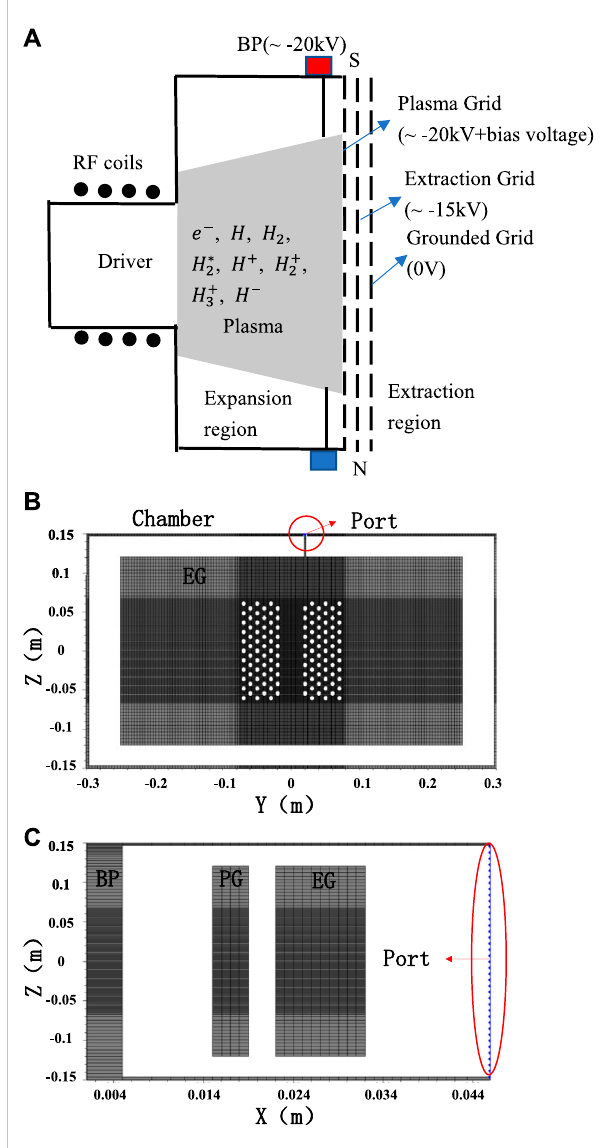
FIGURE 2 (A) Schematic view of negative hydrogen ion source; (B) . The distribution diagram of the aperture tunnels on the EG; (C) . The schematic diagram of the simulation domain in the X-Z direction.